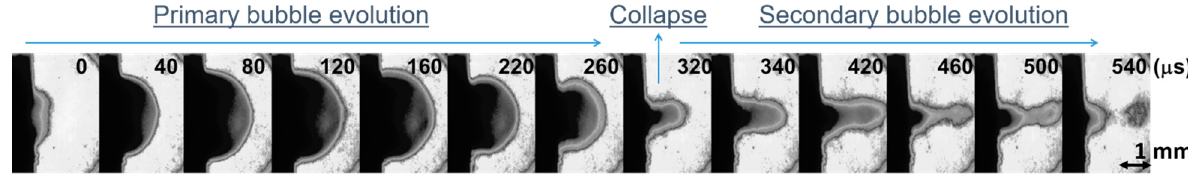
Figure 7. Time-resolved shadowgraph images of the laser-induced bubble on Ag target immersed in water. (Laser pulse width = 6 ns, laser energy = 50 mJ, laser wavelength = 532 nm, laser frequency = 2 Hz, crater sizes = 1 ± 0.2 mm, ICCD gate width = 20 μ s, 5 accumulations for each image).